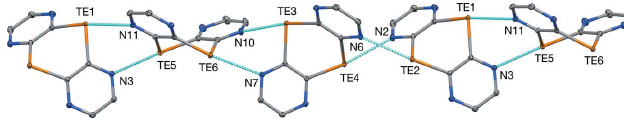
Figure 3 A portion of the helical chain, side view.